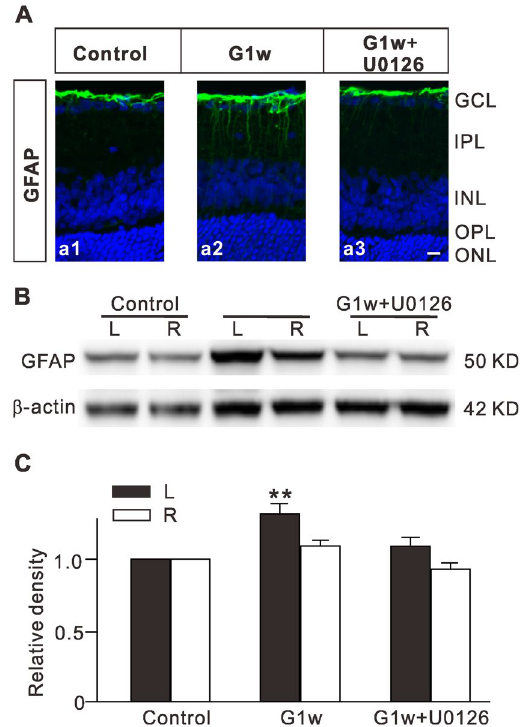
Figure 6. Intravitreal injection of U0126 inhibits upregulation of GFAP expression in Müller cells of retinas with COH. ( A ) Immunofluorescence labeling showing GFAP expression profiles (green) in rat retinal vertical sections, taken from sham-operated retina (control) (a1), COH retina 1 week after the operation (G1w) (a2), and COH retina with U0126 injection (a3). U0126 (10 µ M, 2 µ L) was intravitreally injected 3 days prior to the COH operation. ( B ) Representative immunoblots showing the changes in GFAP levels in control and COH retinal extracts obtained from both operated eyes and their unoperated contralateral eyes with or without U0126 injection. ( C ) Bar charts summarizing the average densitometric quantification of immunoreactive bands of GFAP protein expression under different conditions. n = 6 for each group. ** P < 0.01 vs . left eyes in